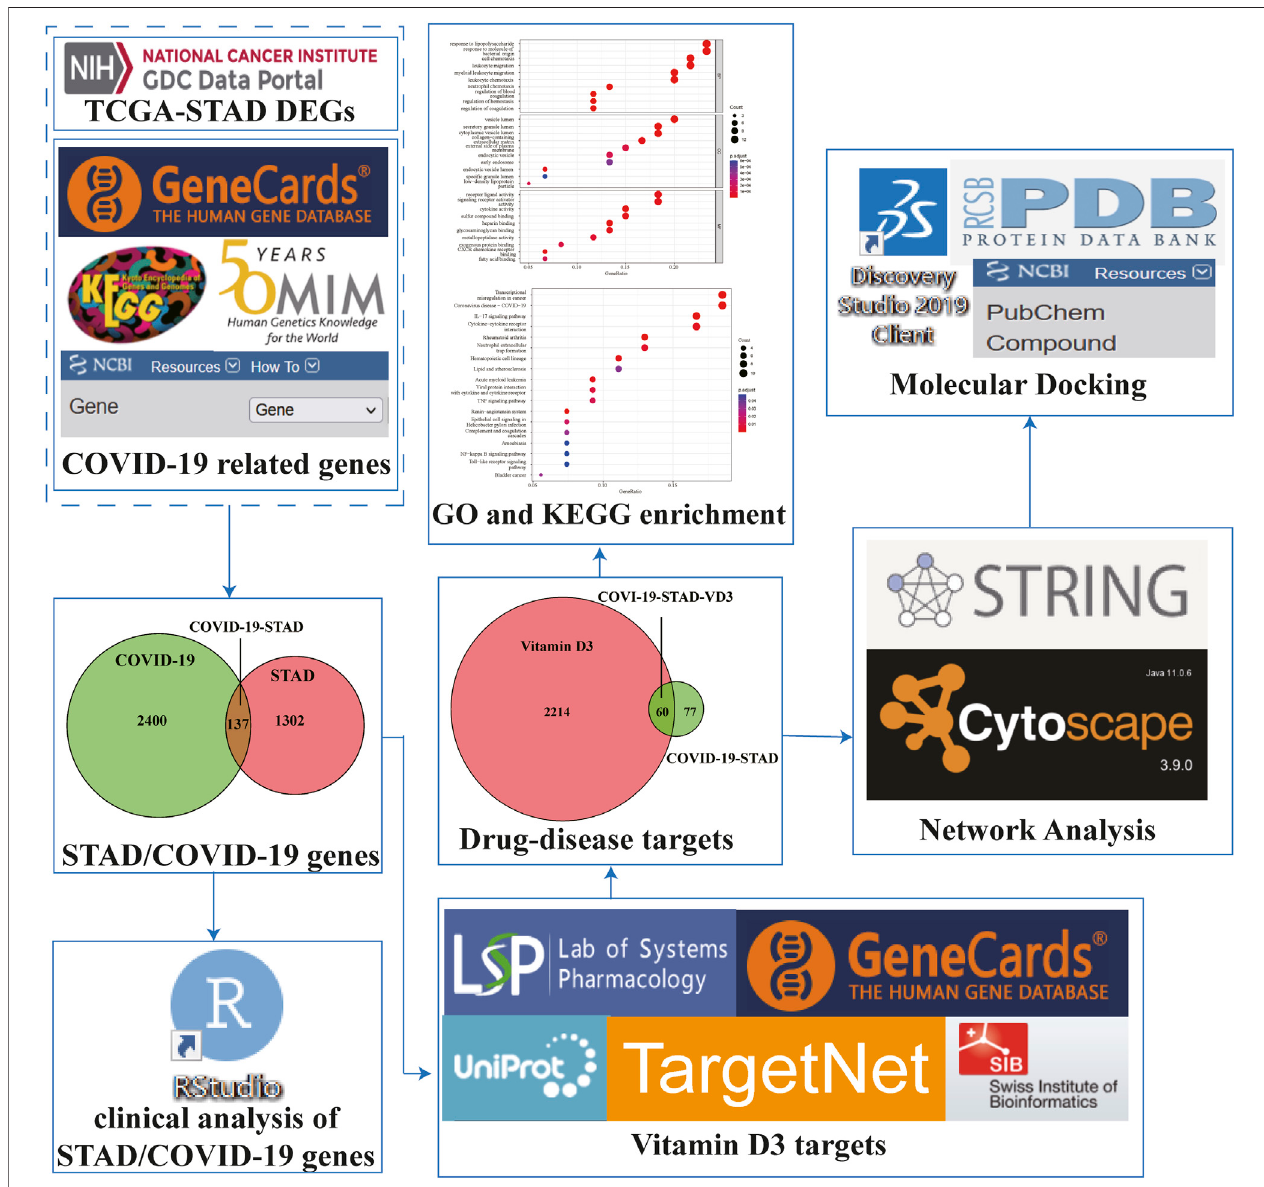
FIGURE 1 | Work fl ow to investigate the anti-STAD/COVID-19 action and mechanism of vitamin D3.